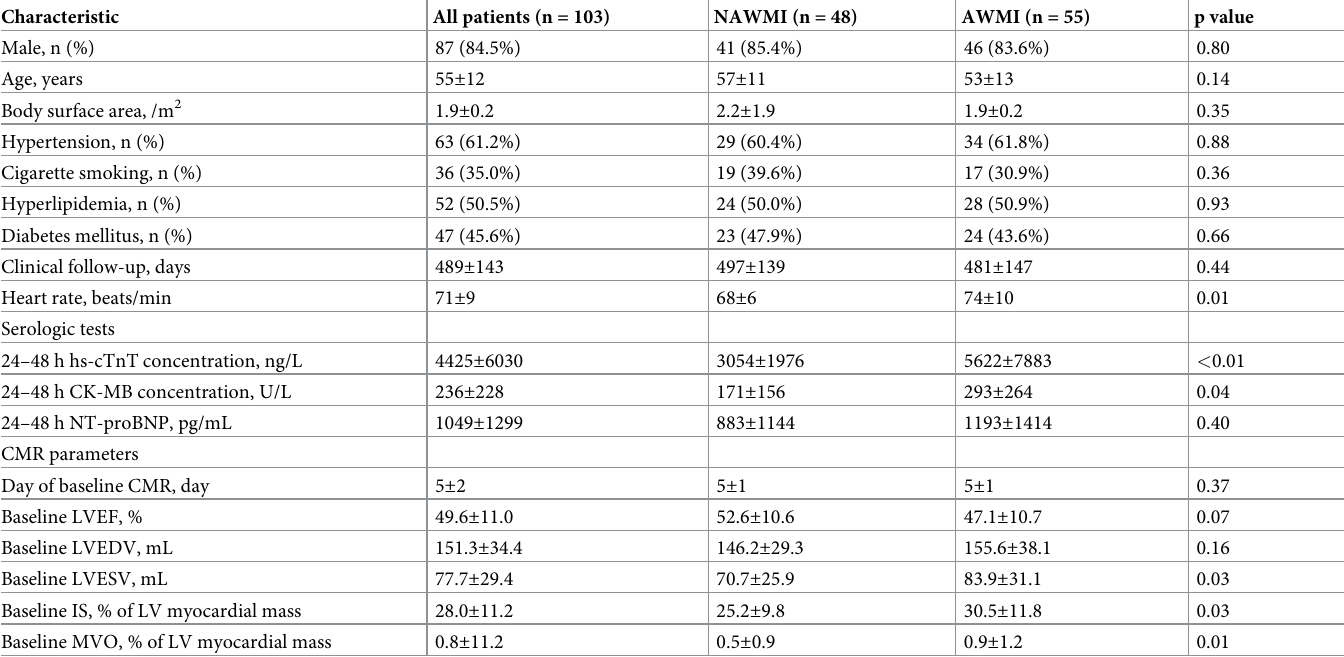
Table 1. Baseline characteristics and cardiac magnetic resonance parameters of study